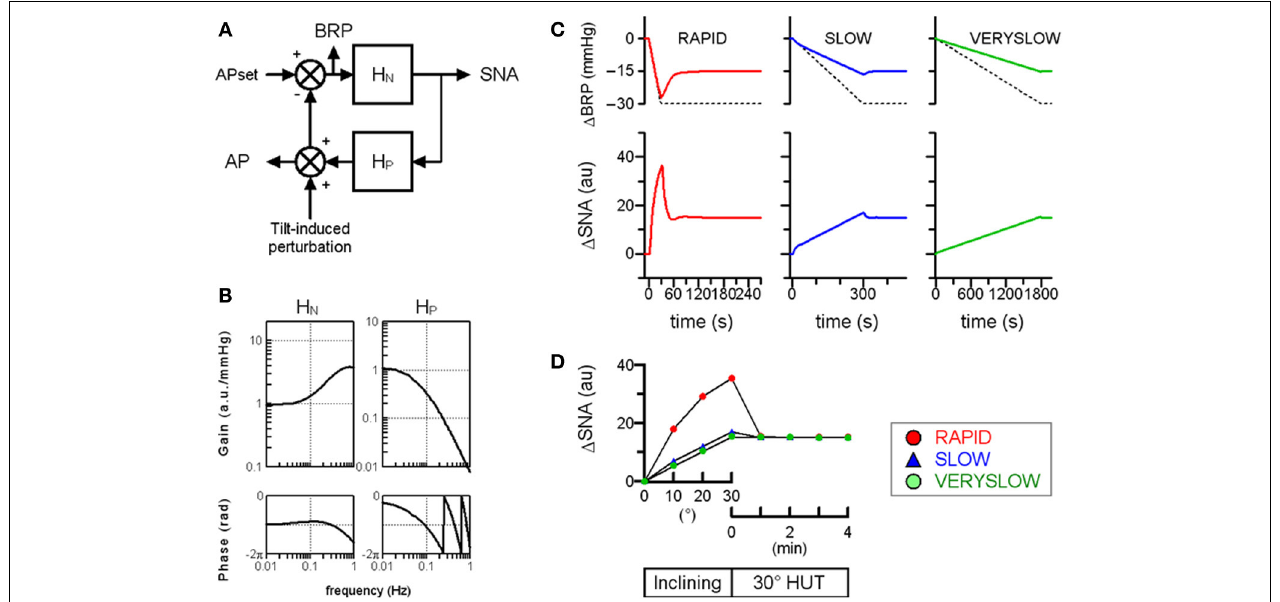
FIGURE 3 | Simulation of orthostatic activation of SNA in response to HUT at different inclining speeds in the baroreflex closed-loop condition. (A) A block diagram of total arc baroreflex system that contains the neural arc transfer function ( H N ) and theperipheral arc transfer function ( H P ). We assigned maximum tilt-induced perturbation of − 30mmHg in the simulations, equivalent to − 1, − 0 . 1, and − 0 . 0167mmHg/s in RAPID, SLOW and VERYSLOW HUT tests, respectively. We set APset at 100mmHg. BRP; baroreceptor pressure. (B) The gain and phase function of H N and H P . In the model of H N , the gain (K N ) is set at 1au/mmHg, while the remaining parameters are set similarly in Figure 2 . In the model of H P , the K P , f N , ζ and L